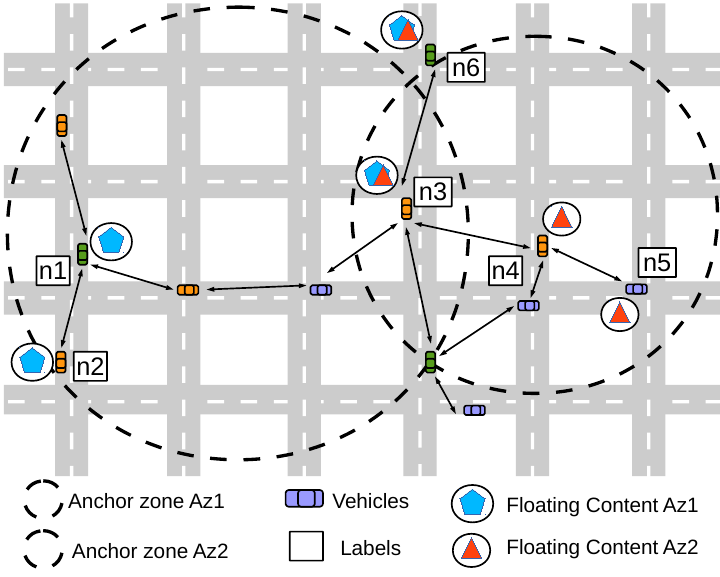
Figure 1. Representation of two different anchor zone ( AZ ) and their respective floating content